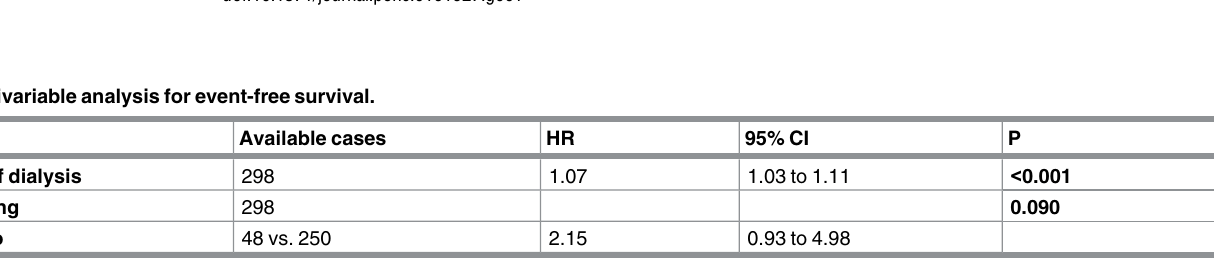
Fig 1. Event-free survival by graded ESC (A), PROCAM (B) and Muenster (C) score. Shown are the performances of low, intermediate and high risk groups for each score.